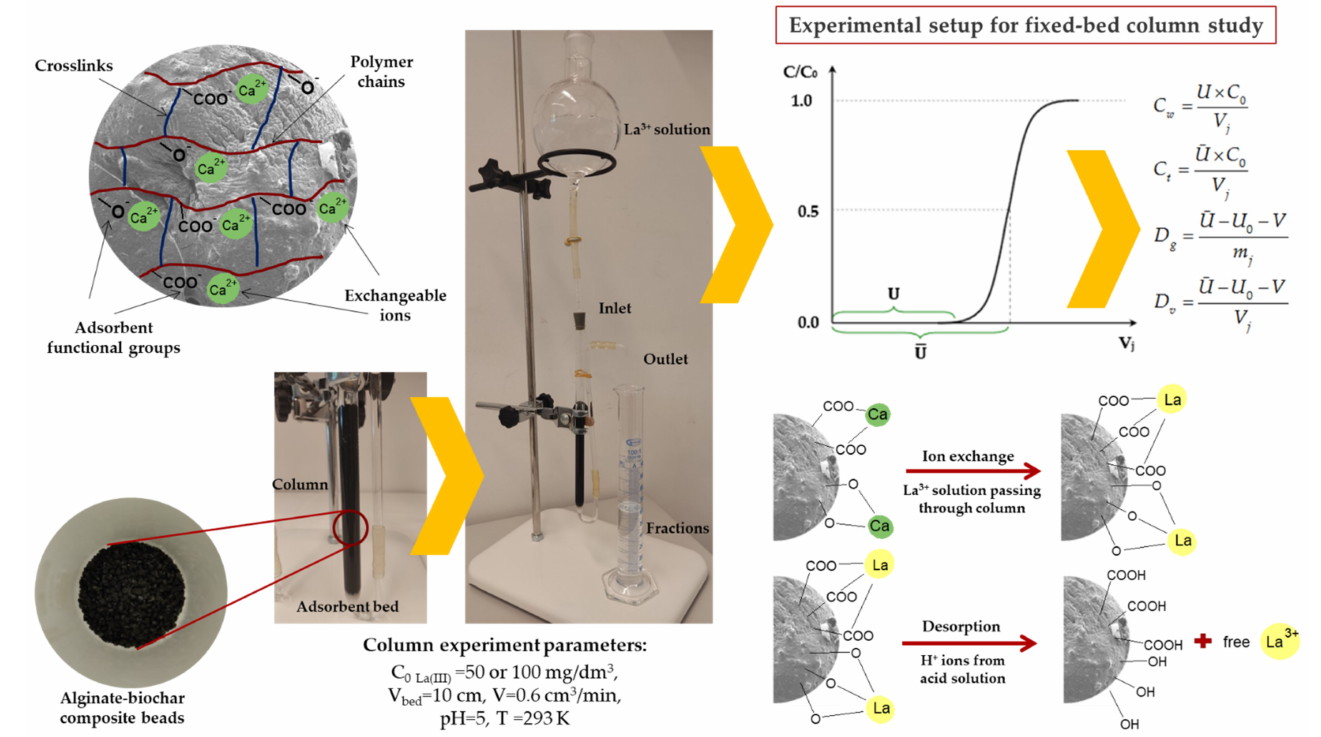
Figure 3. Fixed-bed adsorption column schematic for an experimental